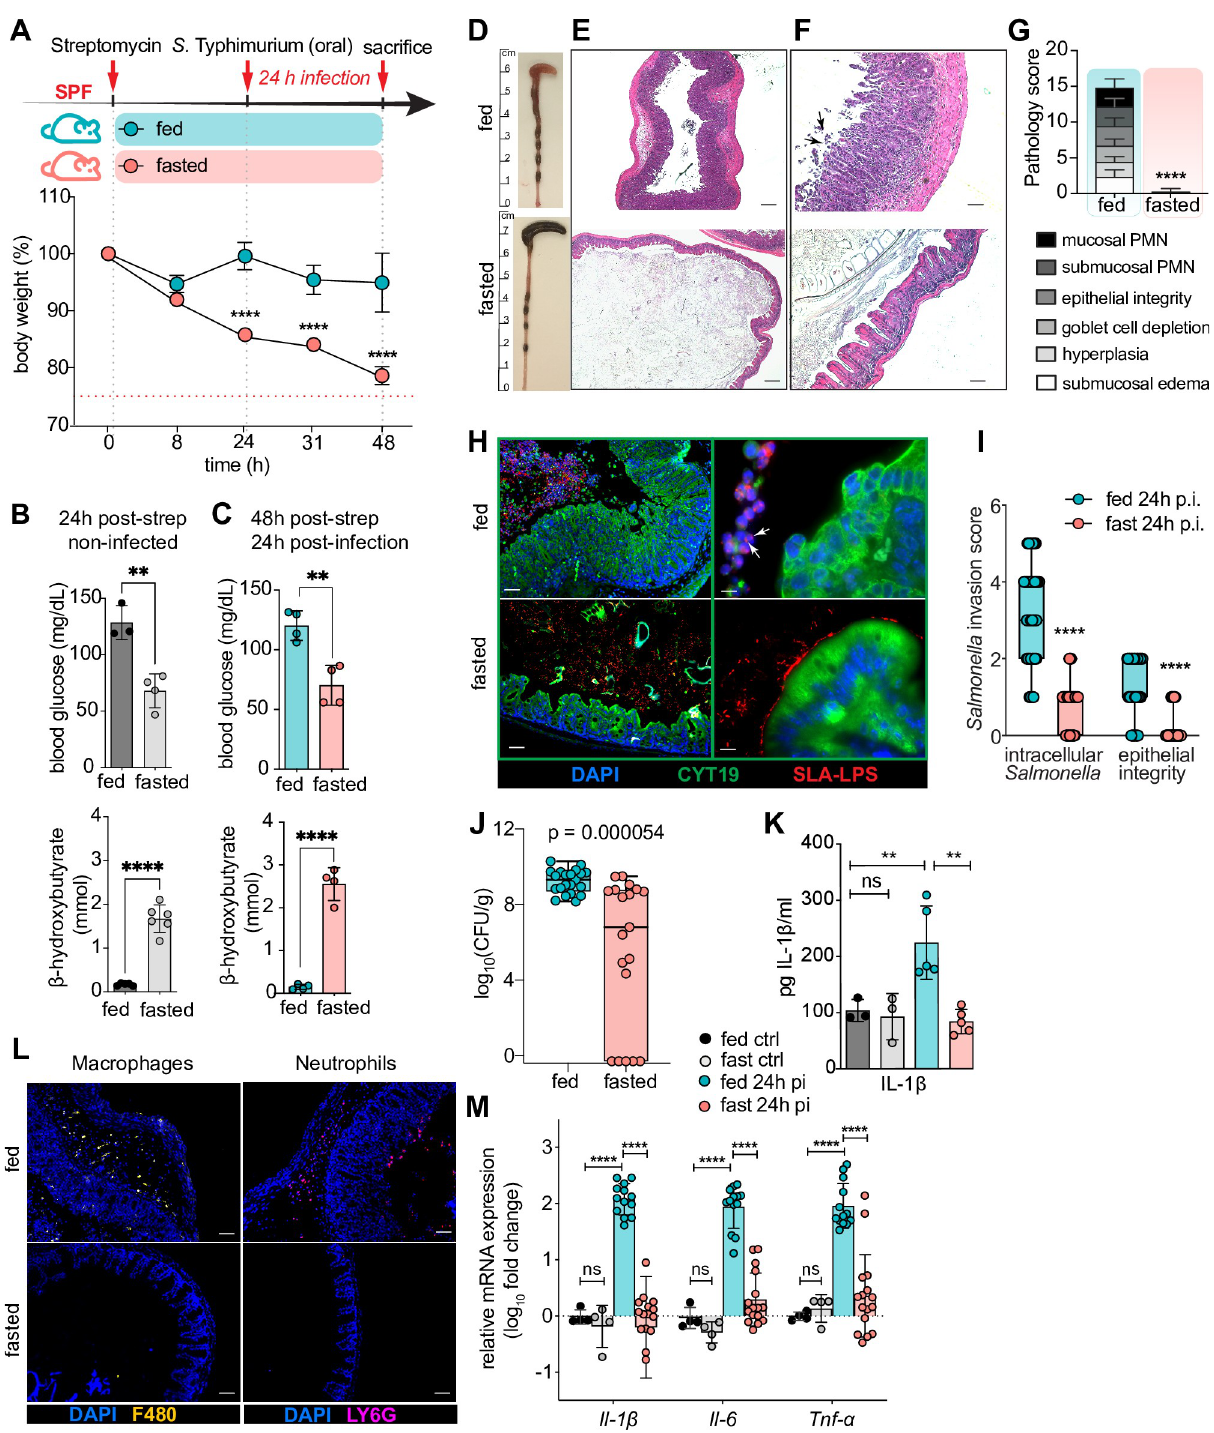
Fig 1. S . Typhimurium-induced gastroenteritis and accompanying inflammatory responses are abrogated by fasting and S . Typhimurium remains luminal in fasted mice. (A) Experimental timeline of infection and fasting regimen and concurrent body weight loss. Streptomycin-pretreated SPF (specific pathogen free) C57BL/6 mice were orally gavaged with ~ 2.5 × 10 6 colony-forming units (CFU) of S . Typhimurium and sacrificed 24h p.i. (n = 5/group) (B) blood glucose and β -hydroxybutyrate levels in mouse serum at 24h post streptomycin treatment ± 24h of fasting. (C) blood glucose and β -hydroxybutyrate levels in mouse serum at 24h p.i. with S . Typhimurium ± 48h of fasting. (D) Representative macroscopic images of mouse cecal and colonic pathology 24h p.i. with S . Typhimurium ± 48h of fasting. (E-F) Representative hematoxylin-and-eosin (H&E)-stained cecal sections of mice